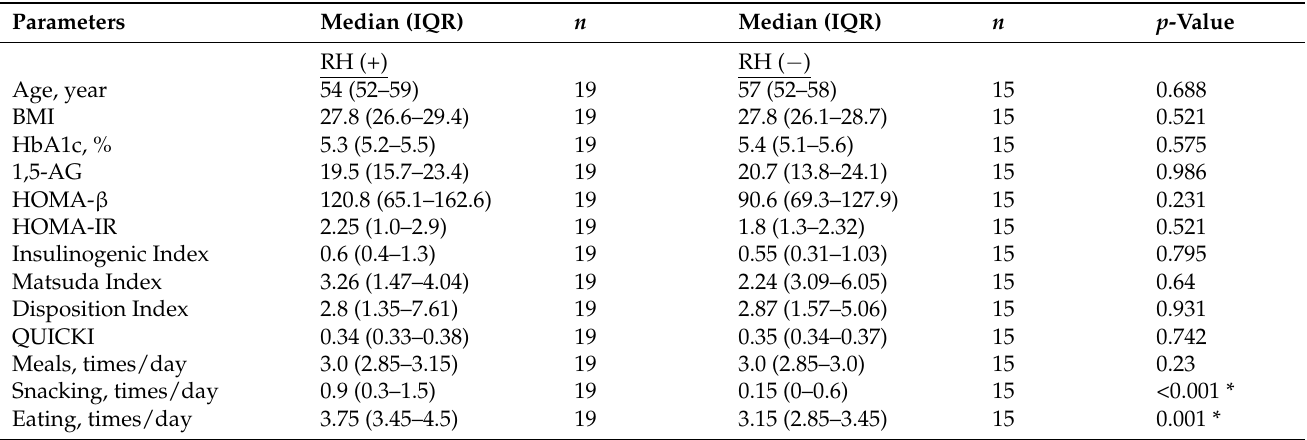
Table 3. Median (IQR) of anthropometric, glucose/insulin, and eating behavior-related parameters in the presence or the absence of reactive hypoglycemia.